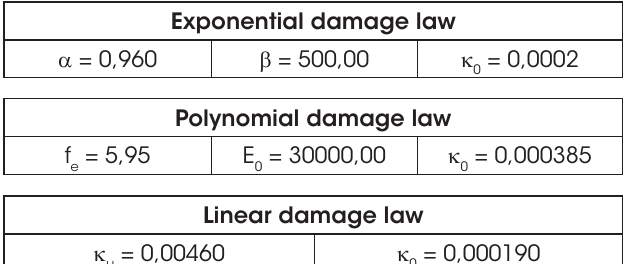
Parameters adopted to the simulations for different laws